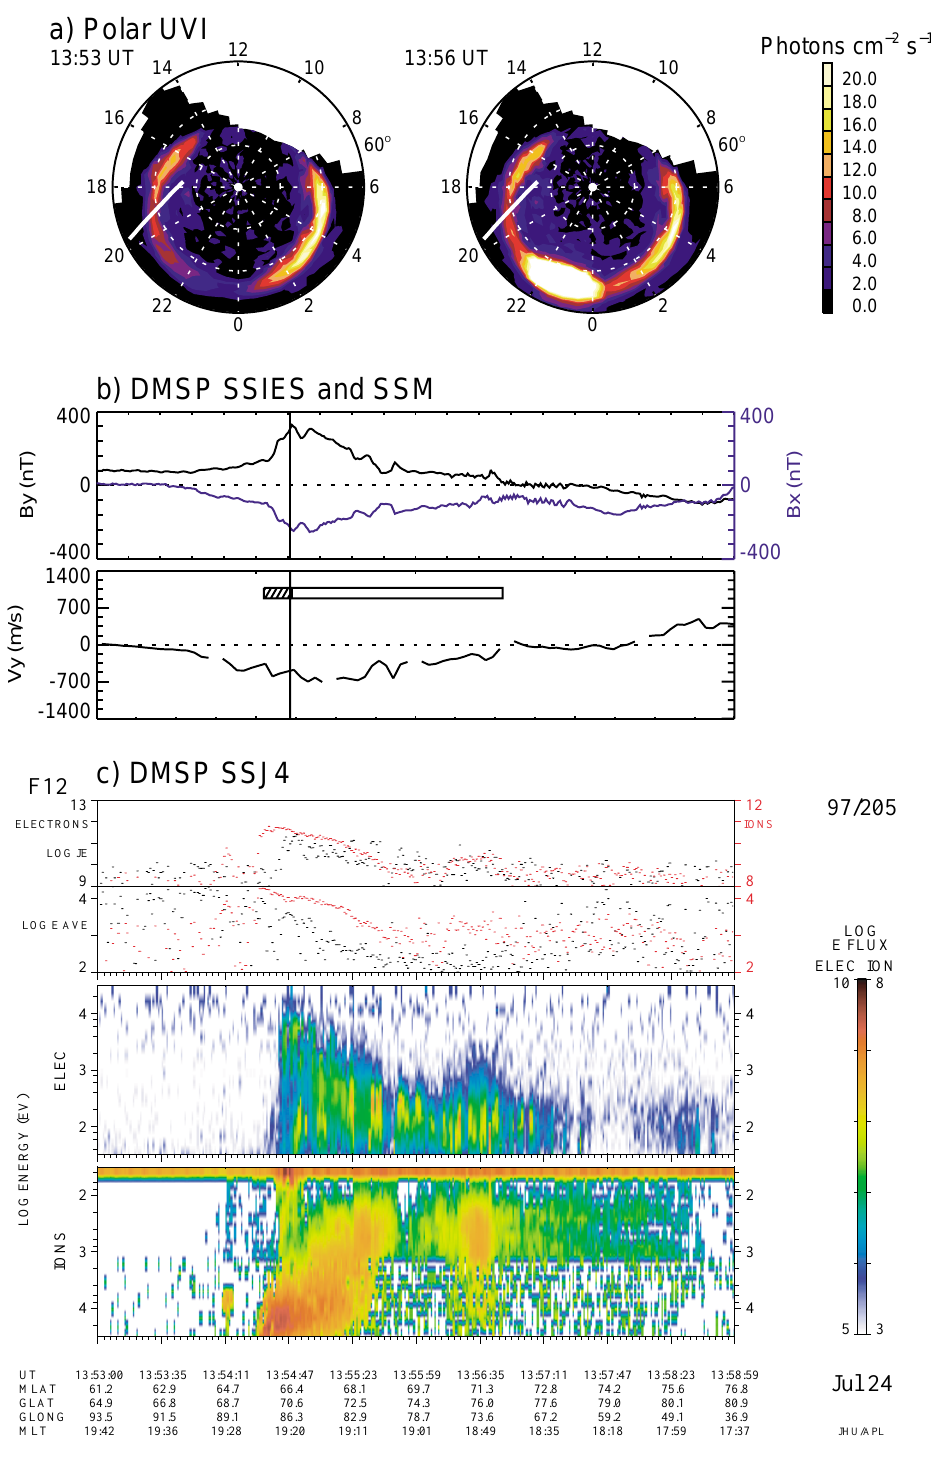
Fig. 4. A summary of observations for the 13:53–13:59 UT, 24 July 1997 event. The format is the same as that for Fig. 2.